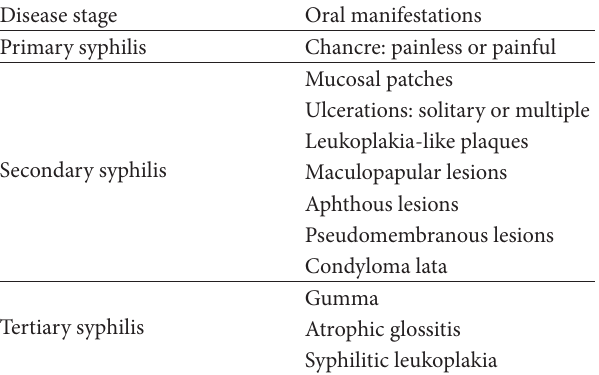
Table 1: The oral manifestations of